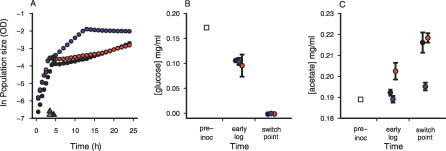

E. coli Growth Profiles of Each Isolated Strain on Glucose/Acetate Mixture and the Change in Glucose and Acetate Concentrations in First Phase of Diauxie(A) Three isolated genotypes (FS, SS, and Anc) consumed glucose (hours 0 to ∼4), then acetate (hours ∼4 until maximum OD), in a standard diauxic (two-stage) growth pattern. The SS (red) closely paralleled the ancestral (black) strain in growth patterns on acetate, while the FS (blue) exhibited a much faster diauxic switch from growth on glucose to growth on acetate and a higher growth rate on acetate (second stage of diauxie). Triangles on the horizontal axis indicate the switching points for each strain.(B) All strains deplete glucose from the medium during the first phase of diauxie (from inoculation into batch culture to the time of diauxic switch).(C) Change of acetate concentration in the medium during the first phase of diauxie. The ancestor and the SS ecotype accumulated acetate as they depleted glucose (Anc: t = 5.418, p = 0.003; SS: t = 11.342, p = 0.0002); however, the FS strain did not accumulate acetate during glucose depletion, indicating that acetate is consumed during growth on glucose (t = 2.769, p = 0.025 not significant at experimentwise α = 0.017). For panels B and C, data are averages ± 1 mean standard error for three replicates, except for a single preinoculation replicate (open square).